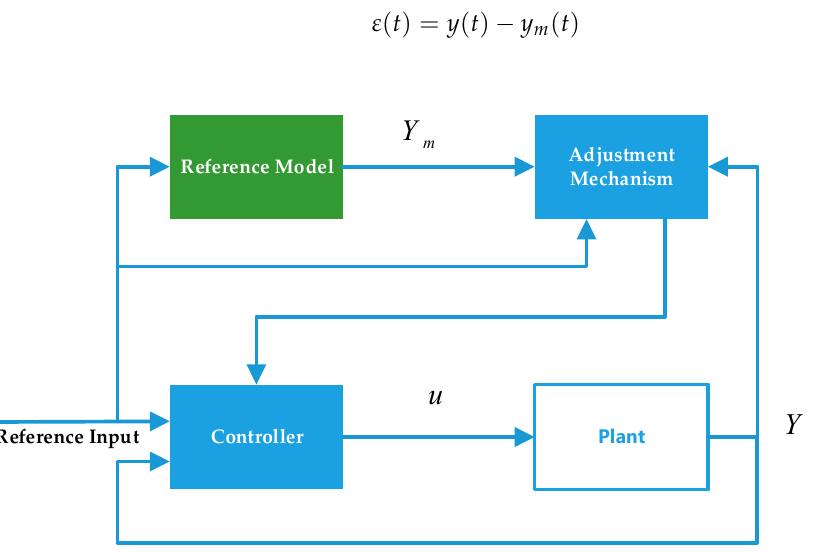
Figure 4. Direct model reference adaptive control system .